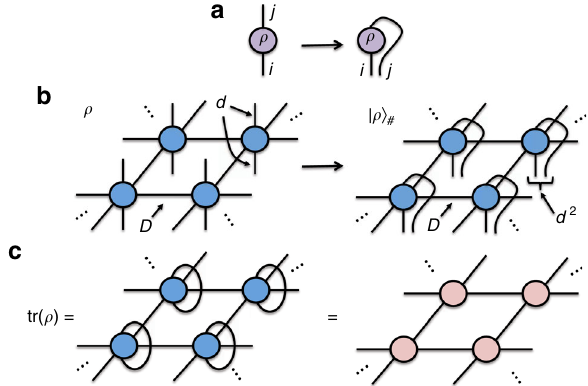
Fig. 1 Relevant tensor network diagrams. a Tensor network diagram for the reduced density matrix ρ , with matrix elements ρ j i . The vectorization is, simply, reshaping the two indices into a single one; b tensor network diagram for the PEPO of ρ on a 2D square lattice, with bond dimension D and physical dimension d . When vectorized, it can be understood as a PEPS for ρ j i # with physical dimension d 2 ; c The trace of ρ maps to the contraction of a 2D network of tensors